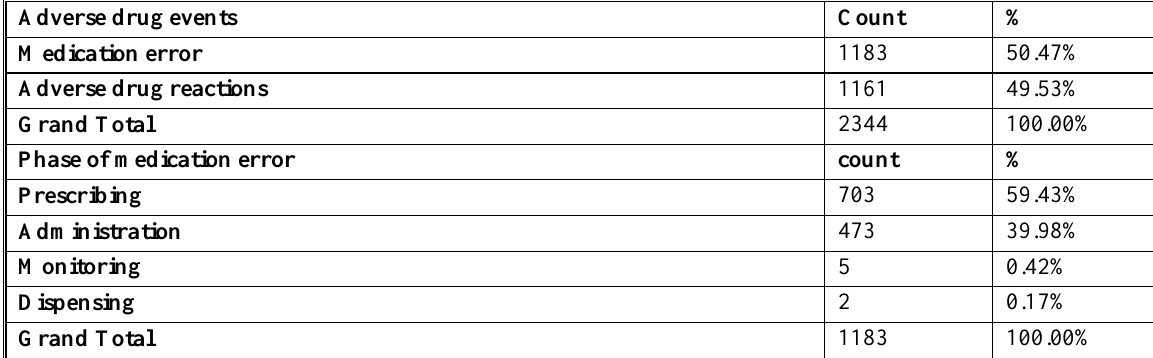
Table 5. Adverse drug event type and phases of medication